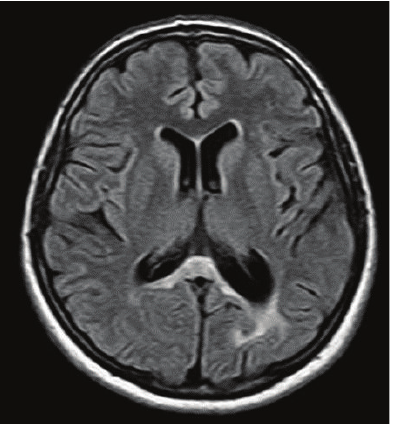
Figure 3: FLAIR-weighted cranial MRI demonstrating important reduction in the lesion following